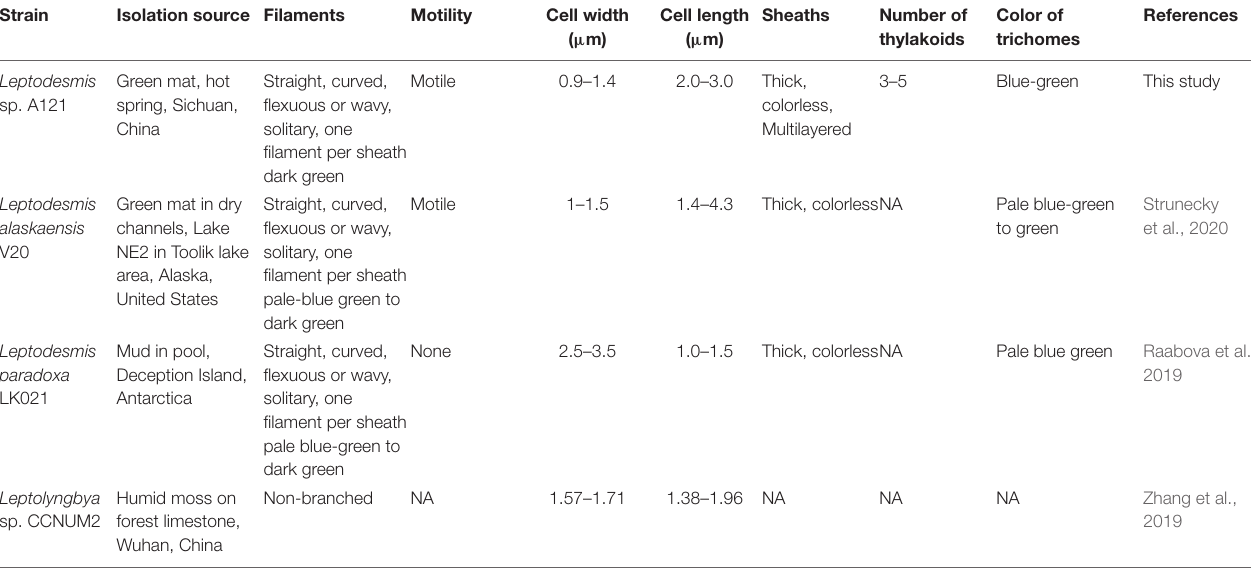
TABLE 3 | Comparison of morphological features of Leptodesmis